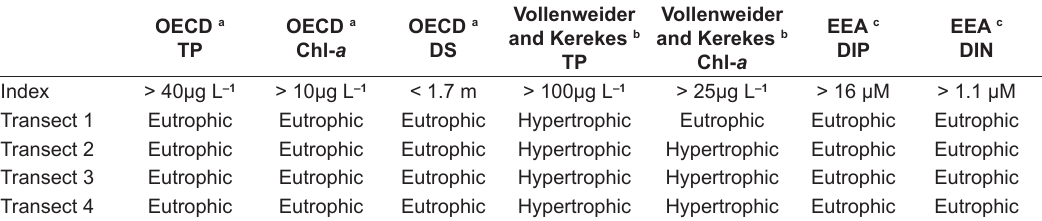
Figure 5. Mixture diagram of total dissolved carbon and nitrogen and nitrogen : phosphorus ratio and total particulate carbon, at Iguaçu River mouth in a salinity gradient from 0 to 12, Guanabara bay, Rio de Janeiro State, Brazil. T1: transect 1; T2: transect 2; T3: transect 3; T4: transect 4. Table 4. Classification of trophic status of Iguaçu River mouth, Guanabara bay, using three different indexes established for marine and coastal environments, where TP= Total Phosphate, Chl - a = Chlorophyll a , DS= Depth of the Secchi, PID= dissolved inorganic phosphorus and NID= dissolved inorganic